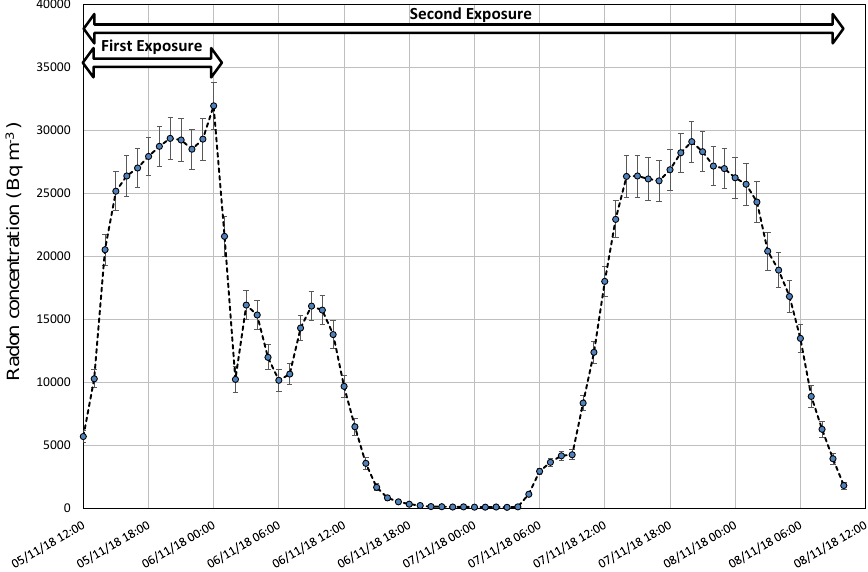
Figure 3. Radon concentration in Room1 during the intercomparison exercise according to LaRUC. Data is displayed every hour.